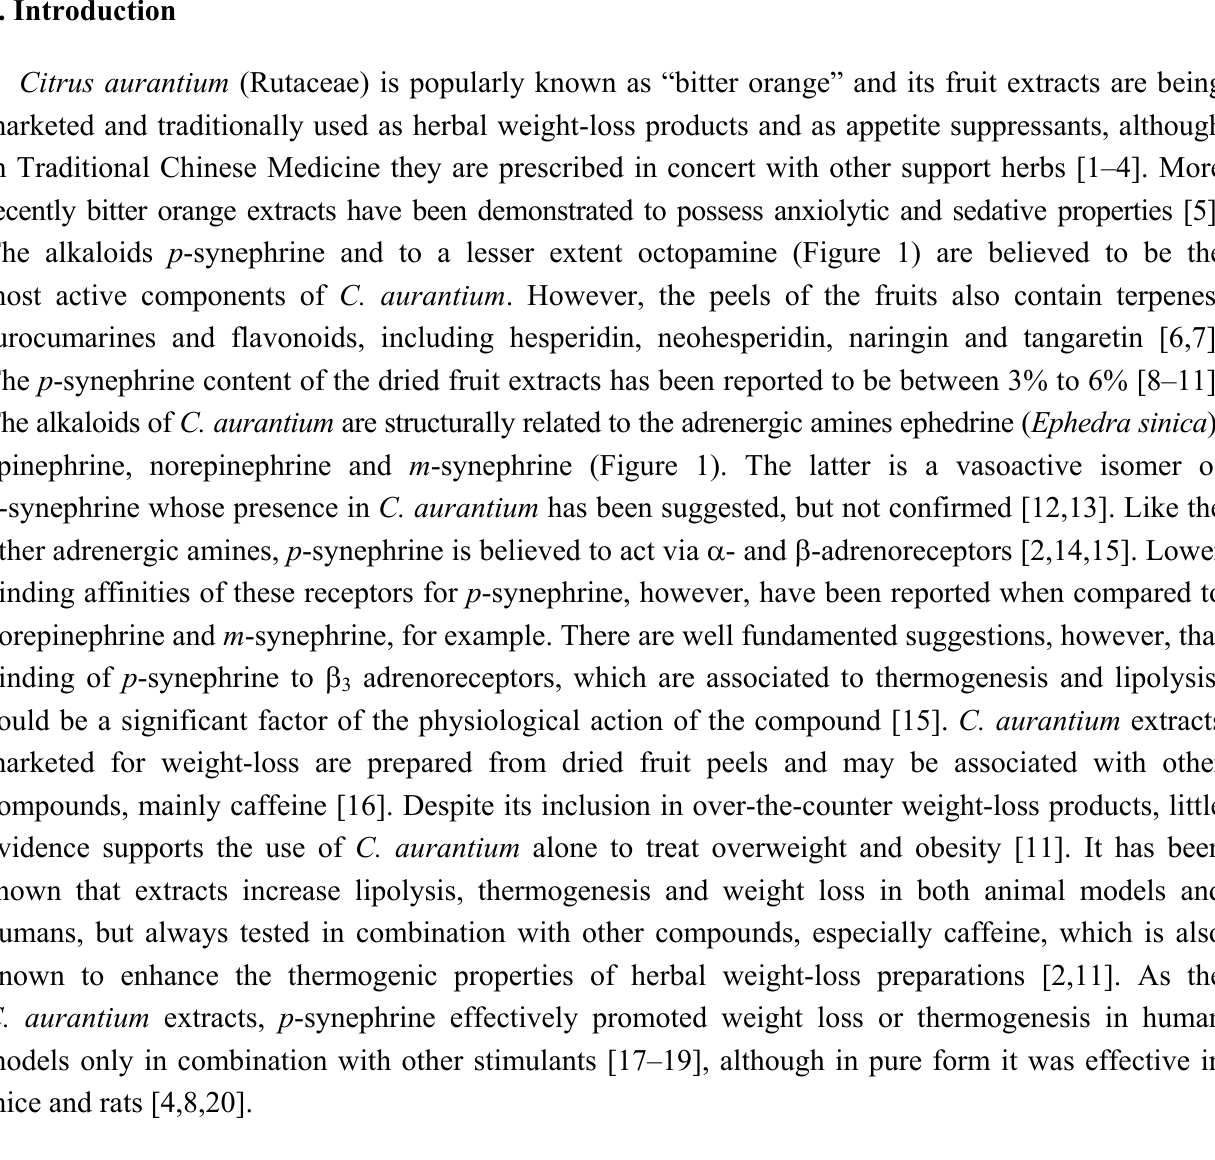
Figure 1. Structural formulae of the C. aurantium alkaloids synephrine, octopamine and related